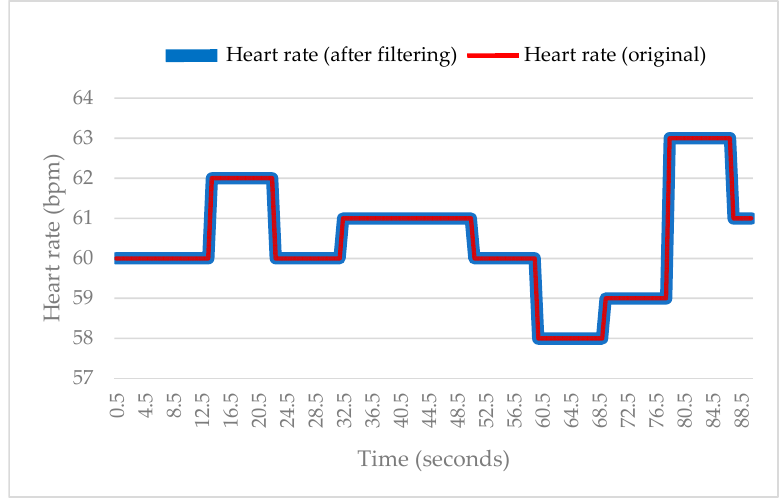
Figure 8. Comparison between original and filtered heart rate when the user was at rest.